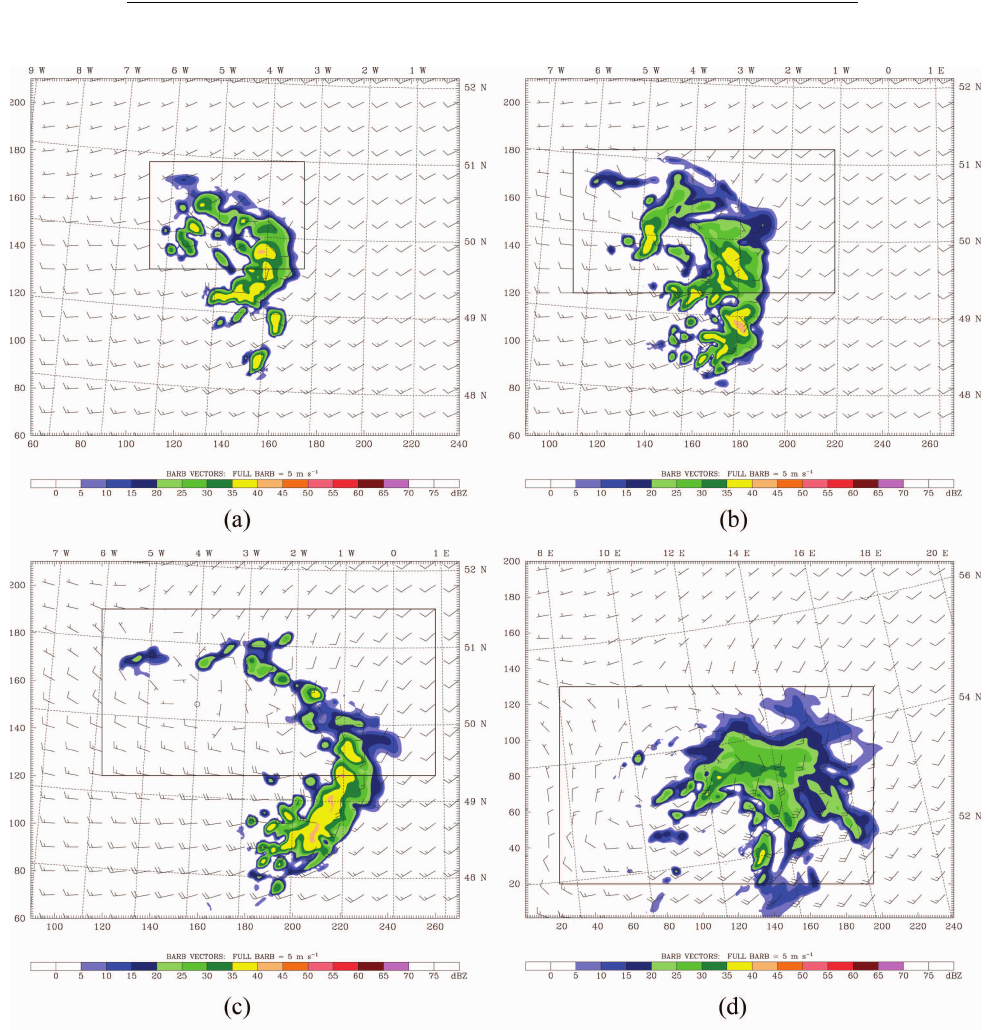
Fig. 1. Model-derived reflectivity (dBz; shading), horizontal flow (barbs; knots) at 700hPa, and analysis boxes at the following times in the control simulation: (a) 129.6h; (b) 132.0h; (c) 136.8h; and (d) 172.8h. The equivalent radar reflectivity factor for rain, Z e (mm 6 m − 3 ), is computed following Fovell and Ogura (1988) as Z e = 720 αkN o λ − 7 (ρ/ρ w ) 2 , where α is the nondimensional ratio of backscattering for the reflecting substance (1 for water, 0.213 for ice), k =10 18 is the conversion factor from m 6 to the units of Z e , N o is the intercept parameter of the raindrop size distribution, ρ the density of the substance of interest (water or ice), and ρ w the density of water. λ is the slope of the raindrop size distribution: λ =( πρ w N o / ρ a q ra ) 1 / 4 , where ρ a is the density of dry air, and q ra the rainwater mixing ratio. The reflectivity is expressed in decibels, or dB Z , where dB Z = 10log 10 ( Ze